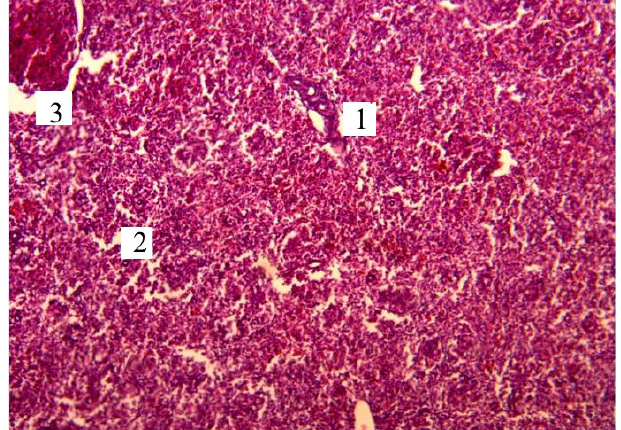
Fig. 3. Microscopic structure of the spleen of a 25-day- old vaccinated chicken: 1 – blood vessels; 2 – red pulp; 3 – white pulp. Hematoxylin and eosin. x 200.